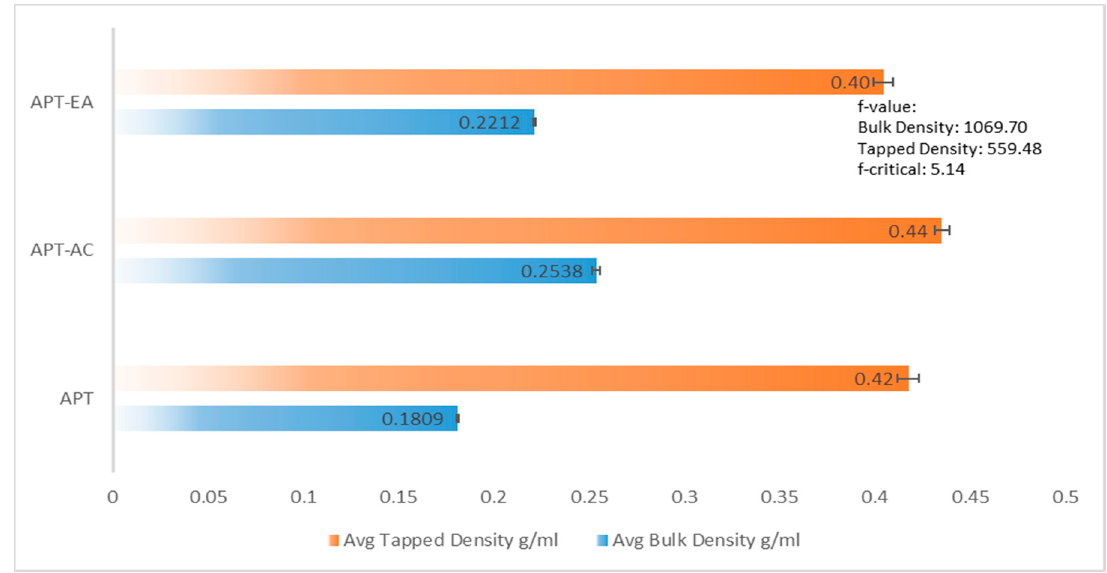
Figure 5. Bulk and tapped density comparison. All values were calculated as mean ± SD, n = 3. ANOVA at the p < 0.05 level showed a significant difference.